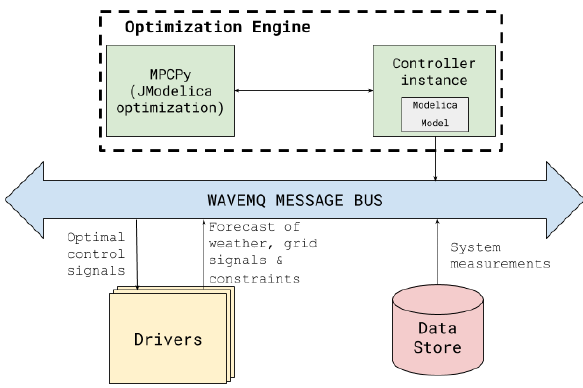
Figure 4. The optimization engine component and its relationship to other parts of